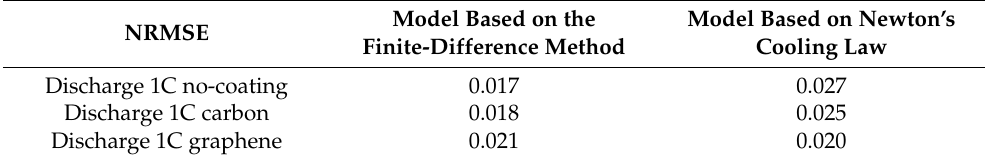
Figure 10. Experimental vs modeled temperature with Newton’s law and finite-differences method for the uncoated battery at discharge rate 1C. Table 6. NRMSE between experimental and modeled curves of temperature at discharge rate 1C.